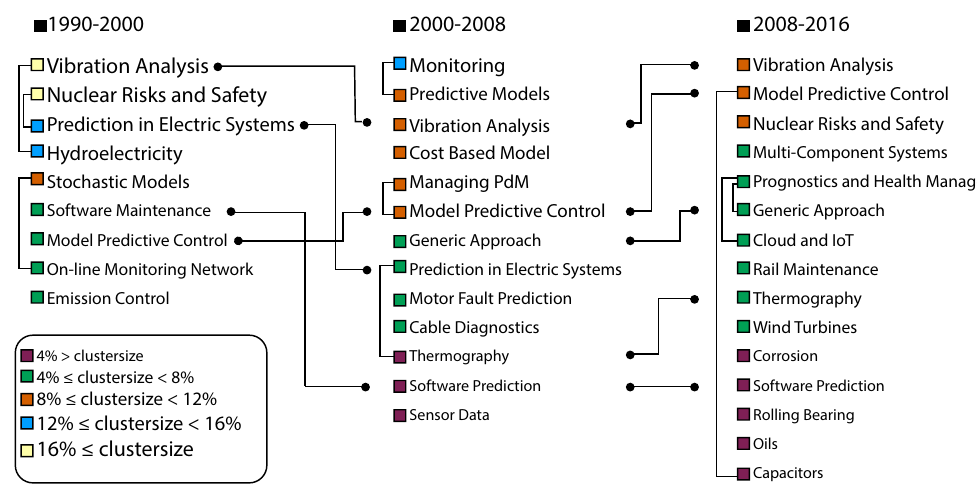
Figure 12. Research Front Flow Diagram (Color and Font